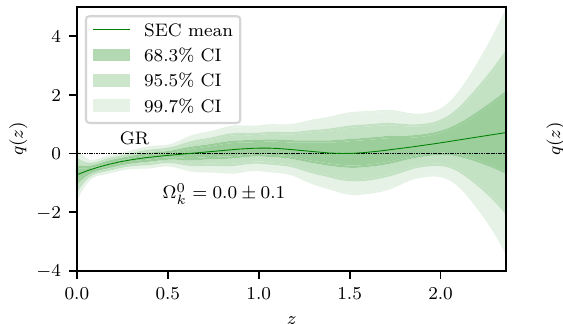
Fig. 2 The green solid lines are the mean estimates of the SEC, and the green shaded areas are the 68.3%, 95.5% and 99.7% CIs at different redshift values obtained from the reconstructed q ( z ) by using SNe Ia + BAO + H ( z ) data. The left painel covers the entire redshift interval